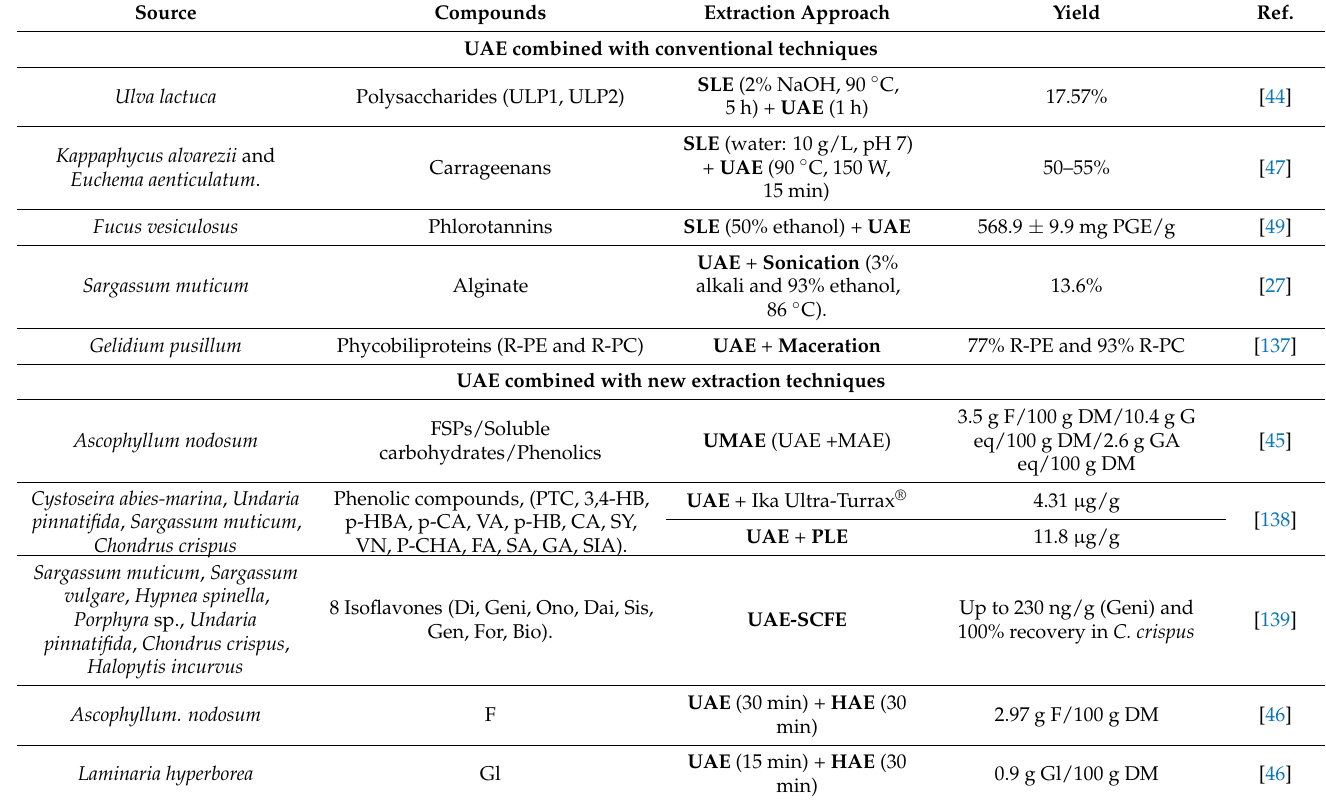
Table 3. Combination approaches of UAE for the extraction of